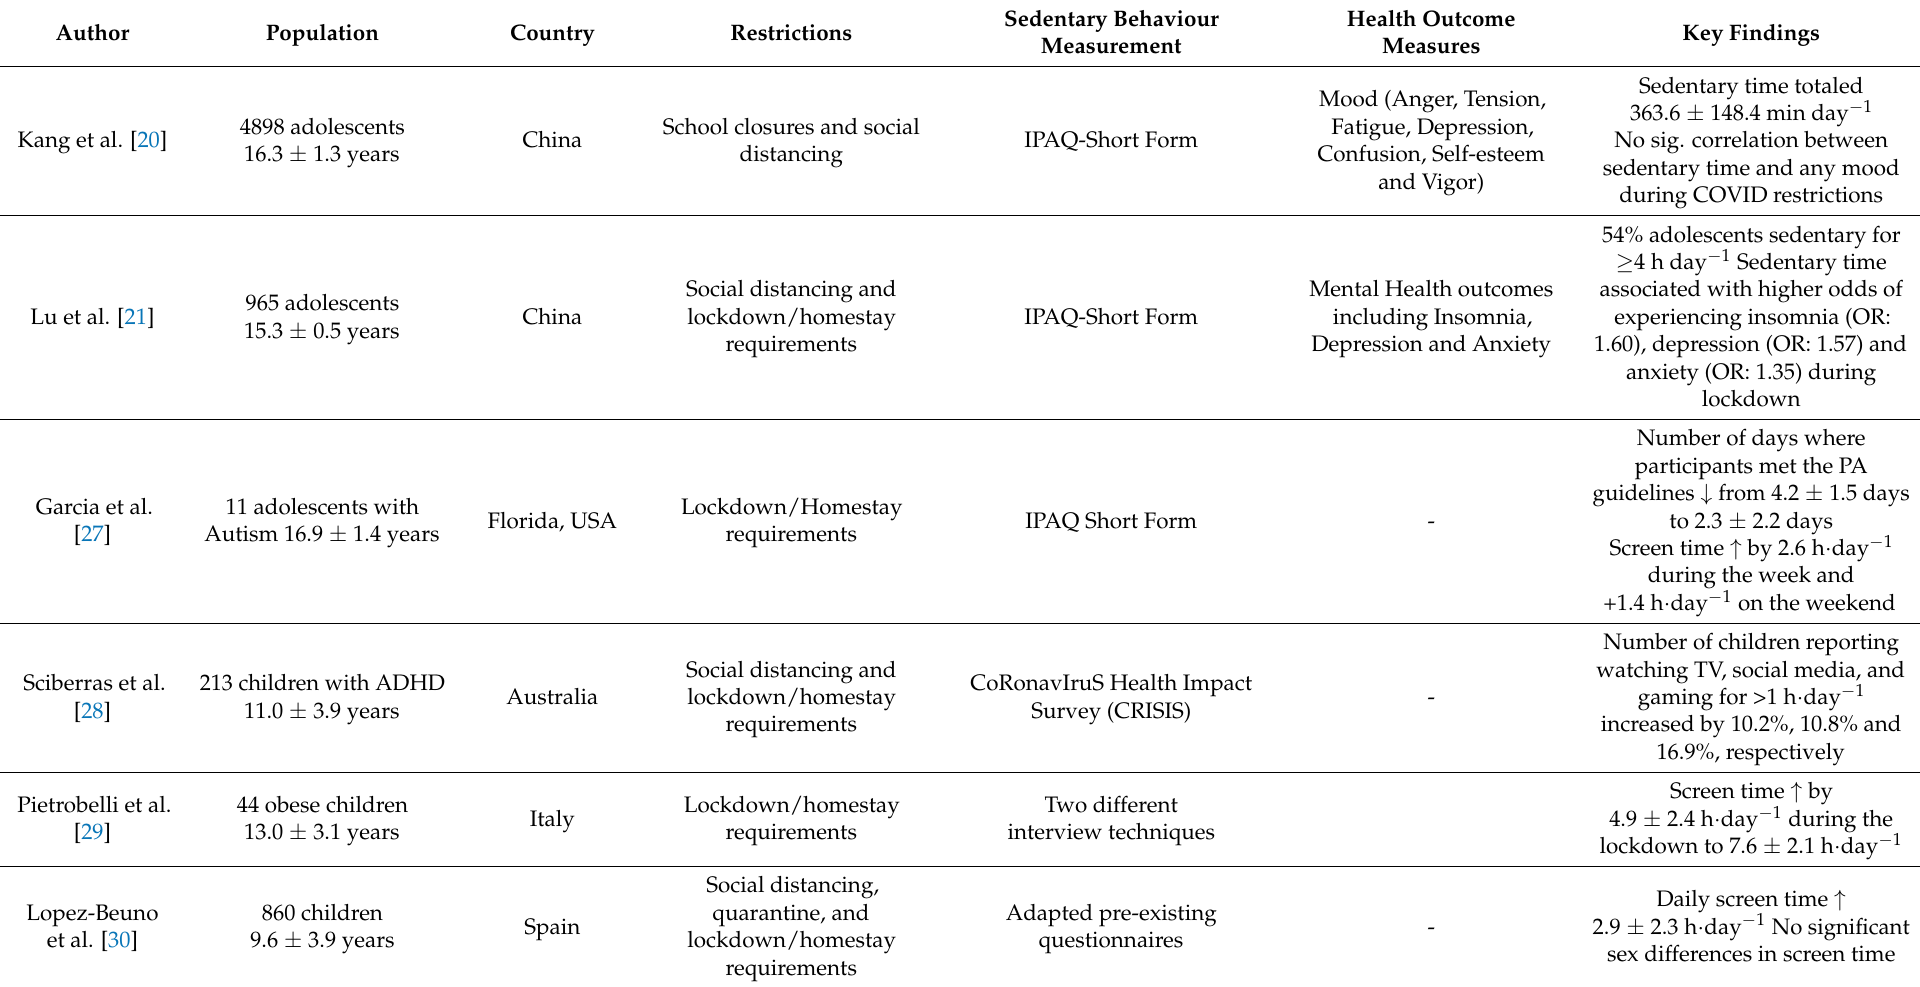
Table 1. Data extraction of studies measuring sedentary time and/or behaviour during COVID-19 in